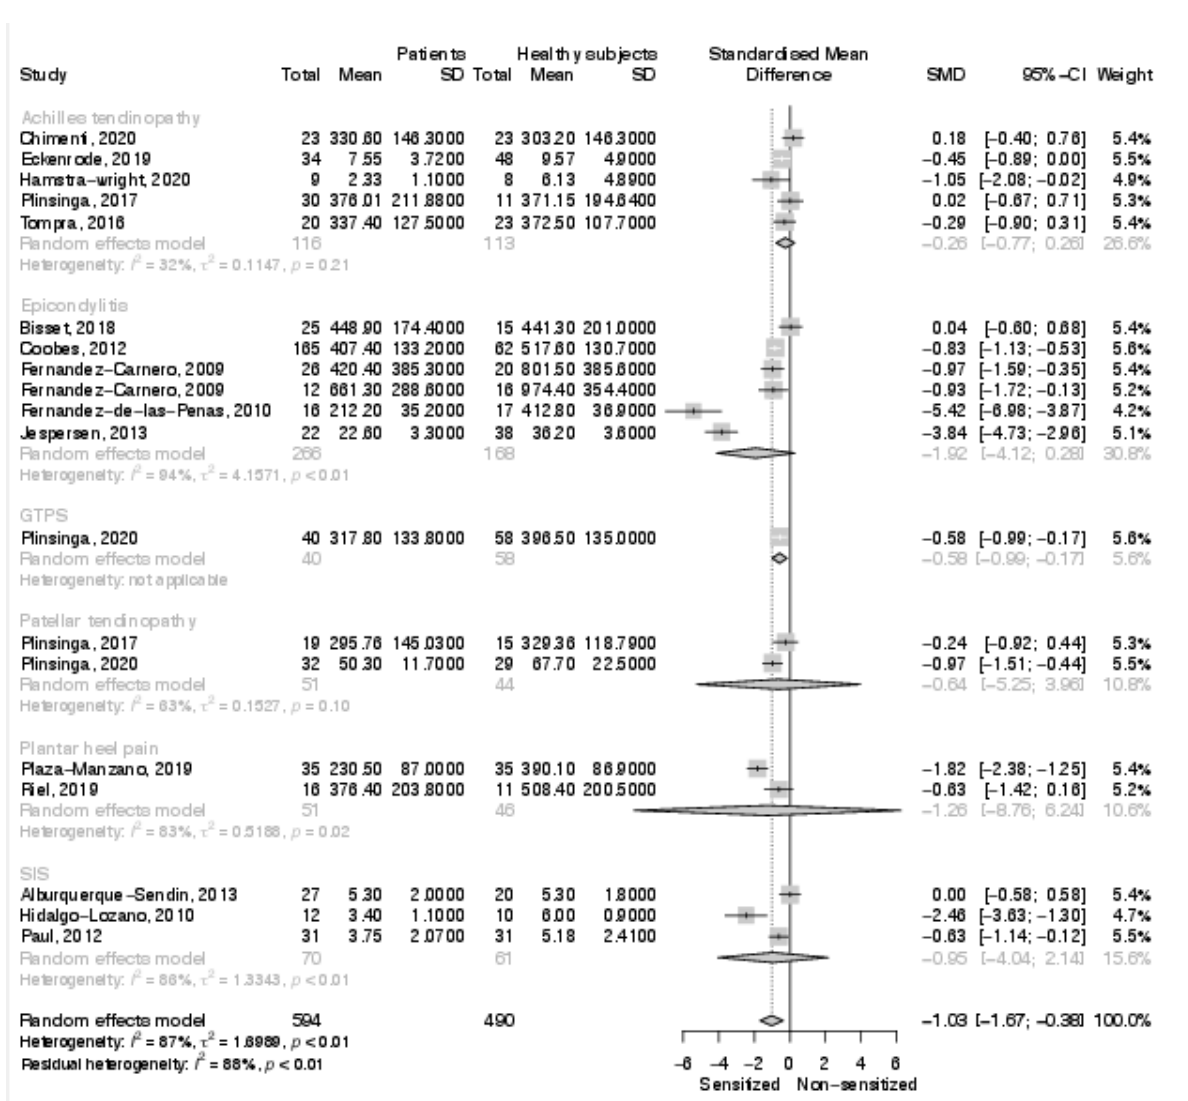
Figure 5. Results of the meta-analysis on distant pressure pain thresholds.